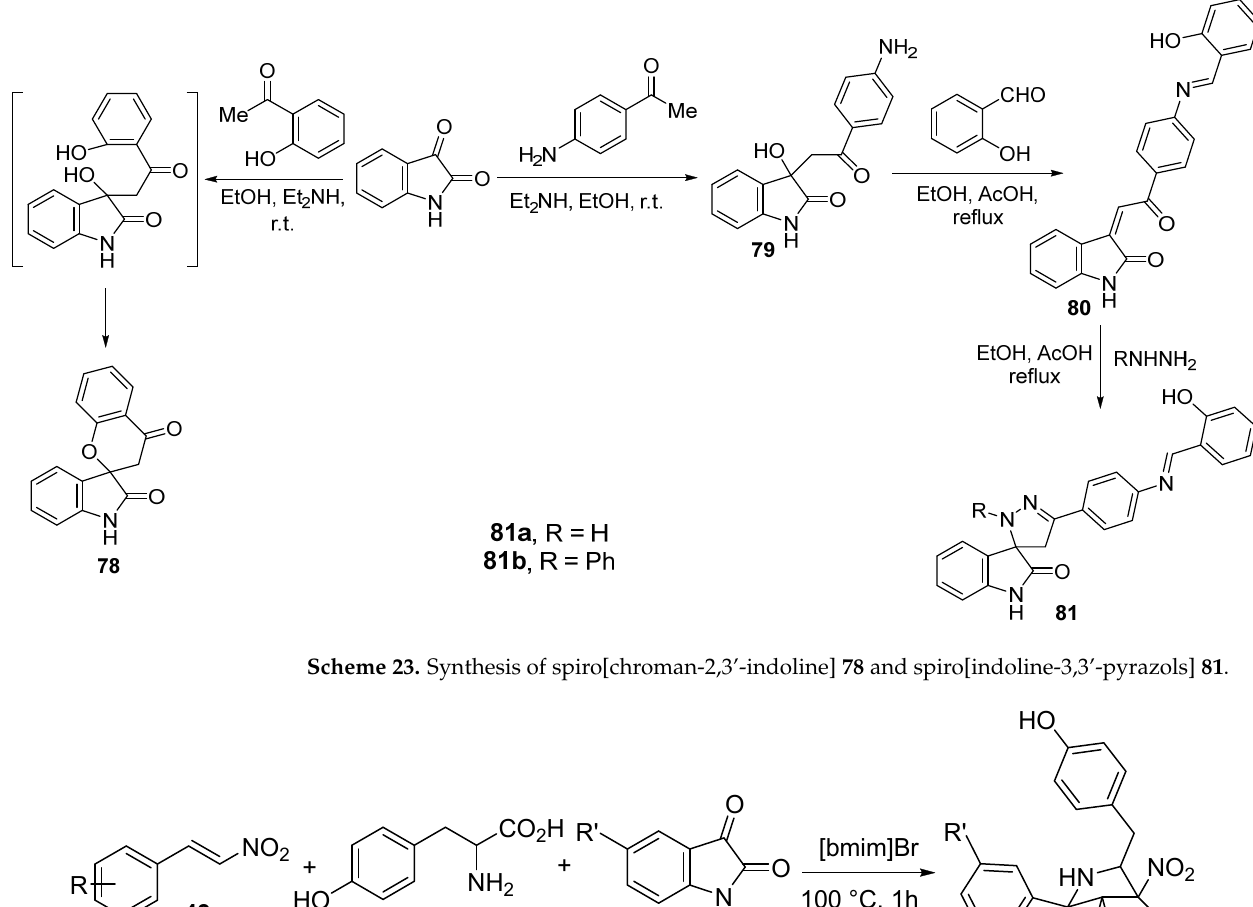
for the most promising agent synthesized with R = 4-OMe, R’ = OCF 3 and Camptothecin,